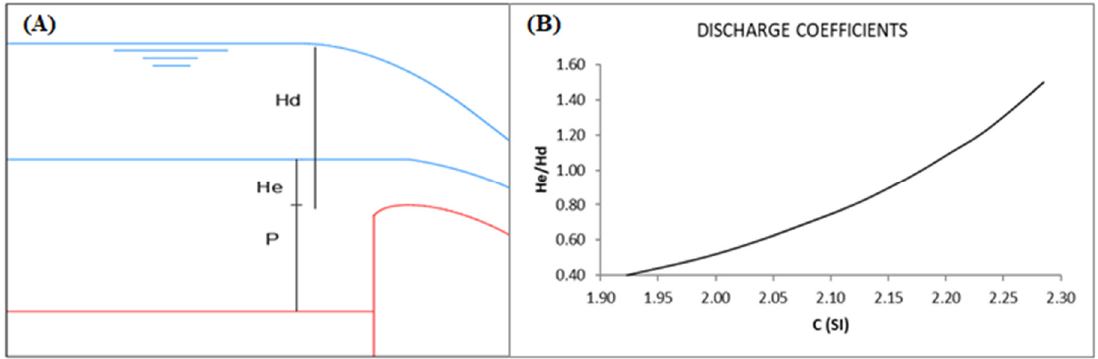
Figure A2. ( A ) Hd, He, and P parameters. ( B ) Spillway discharge coefficient (C) as a function of the relative load on the crest (He/Hd). Adapted from: (U.S. Army Corps of Engineers, 1990). The wall of the spillway, P, influences the discharge coefficient. For a ratio P/Hd >1, flat slopes upstream of the crest slopes tend to produce a decrease in the discharge coefficient. The U.S. Army Corps of Engineers (1990) provided data on the depth of approach and slope effects of the weir face. In this study, the upstream face of the crest is considered vertical and the P/Hd ratio is equal to 1.0. With this parameter, the discharge coefficient C was obtained from Figure A2b).